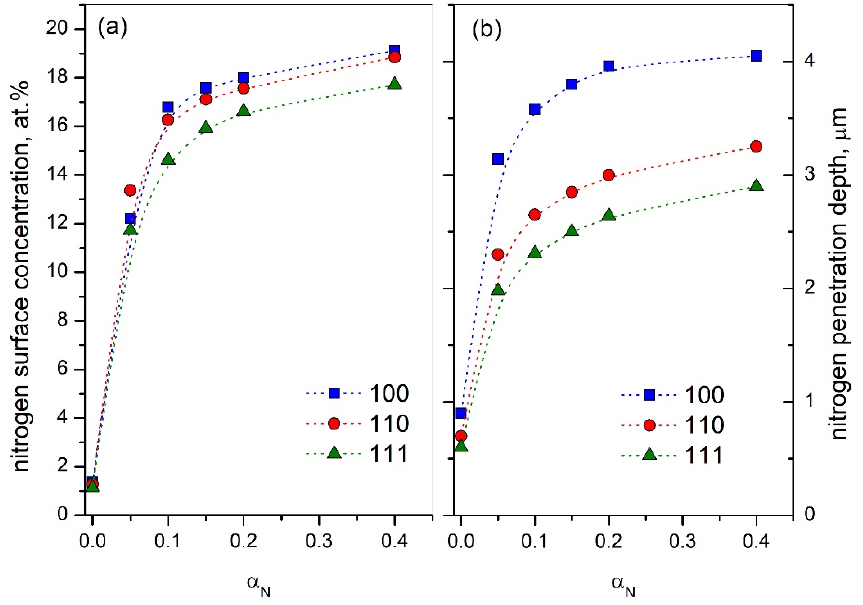
Figure 8. Nitrogen surface concentration ( a ) and nitrogen penetration depth ( b ) as functions of parameter α N (nitrogen adsorption sticking coefficient) for different crystallite orientation.